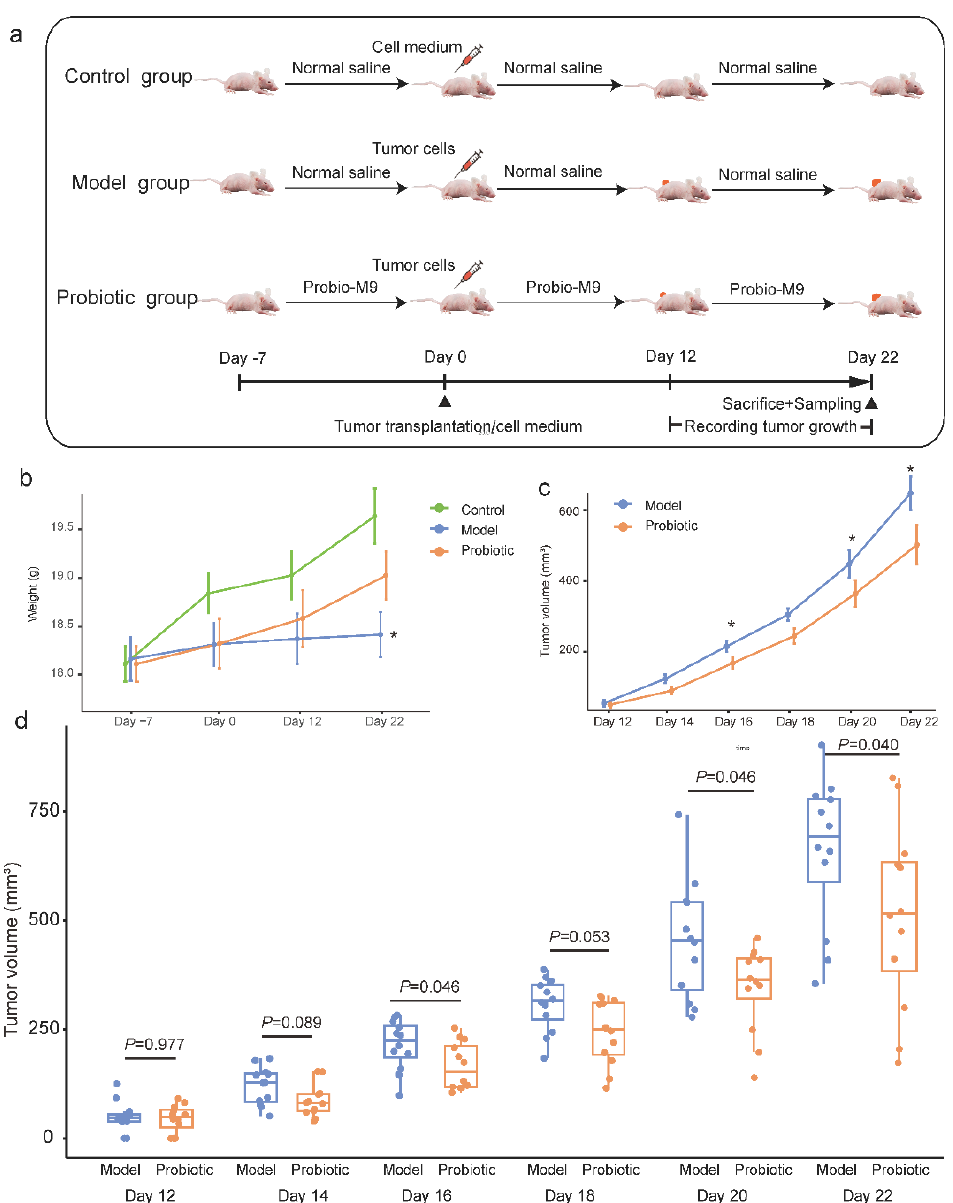
Figure 1. Experimental design and changes in tumor volume in mice. ( a ) A total of 36 mice were randomized into the control, model, and probiotic groups ( n = 12 per group), respectively, for different interventions. Tumor cells were transplanted to the mice in the model and probiotic groups at day 0. Tumor growth was monitored every other day between day 12 and day 22. At day 22, mice were sacrificed, and tumor tissue, fecal and blood samples were collected. ( b ) The line chart shows the changes in the body weight of mice over time. Error bars represent the standard error of the mean. * p < 0.05 (model group versus probiotic group), Wilcoxon test. ( c ) The line chart shows average changes in tumor volume of mice over time. Error bars represent the standard error of the mean. The asterisk represents significant intra-group difference, * p < 0.05, Wilcoxon test. ( d ) The box plot shows changes in the tumor volume during the course of intervention. The p value of each pairwise intra-group comparison was calculated by Wilcoxon test.